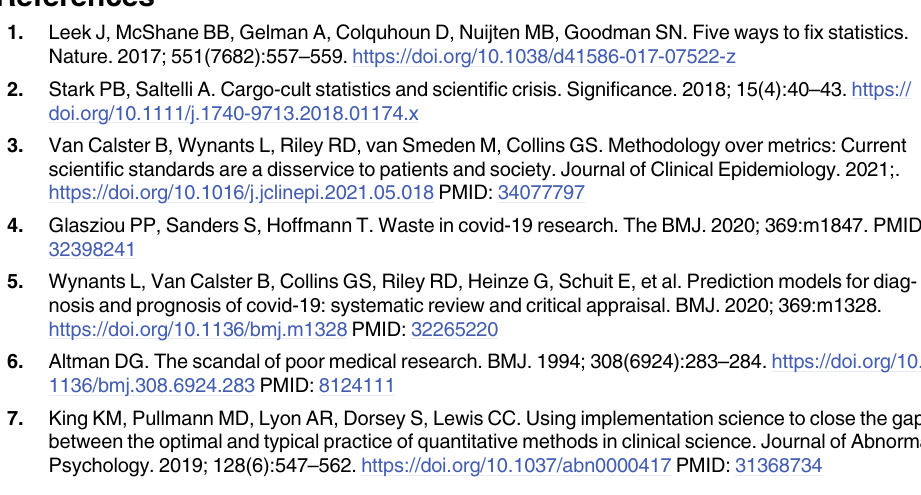
The most frequent combinations of themes are given on the x-axis, with the corresponding number of studies on the y-axis. S4 Fig. Total matching sentences by topic for the ANZCTR dataset. A match was defined any pair of sentences between ANZCTR studies with a Jaccard score equal to 0.9 or higher. S5 Fig. Summary of close matches at the sentence level (x-axis) by ANZCTR themes inferred from common n-grams (y-axis), organized by study design (A) and methods- based (B) topics. A close match was defined any pair of sentences between ANZCTR studies with a Jaccard score equal to 0.9 or